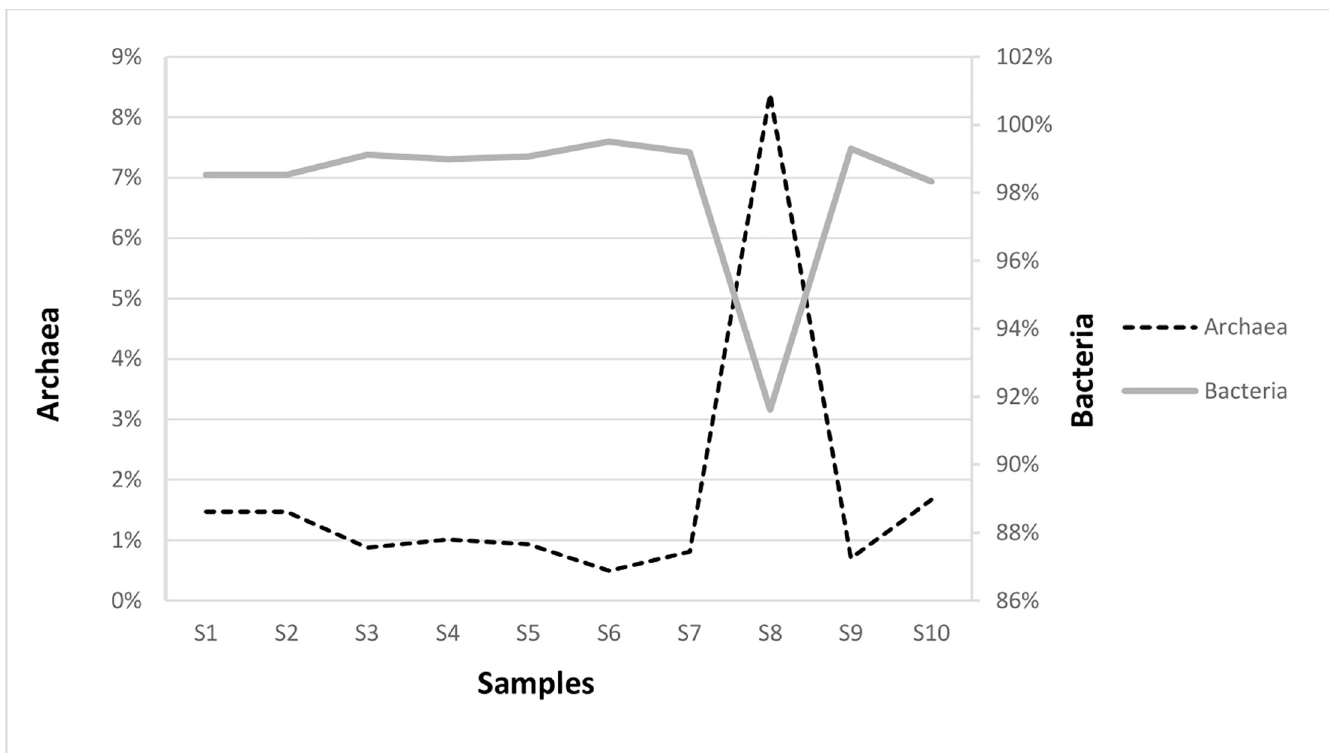
Fig 2. The percentage of Eubacteria and Archaea in the collected samples. https://doi.org/10.1371/journal.pone.0250514.g002 was observed. The community richness of Eubacteria and Archaea in receiving water down- stream the discharge point of treated wastewater was higher than in the surface water upstream the discharge point of treated wastewater. In the case of diversity, the treated wastewater also influenced diversity in the receiving water. The higher values of Shannon and Simpson indices